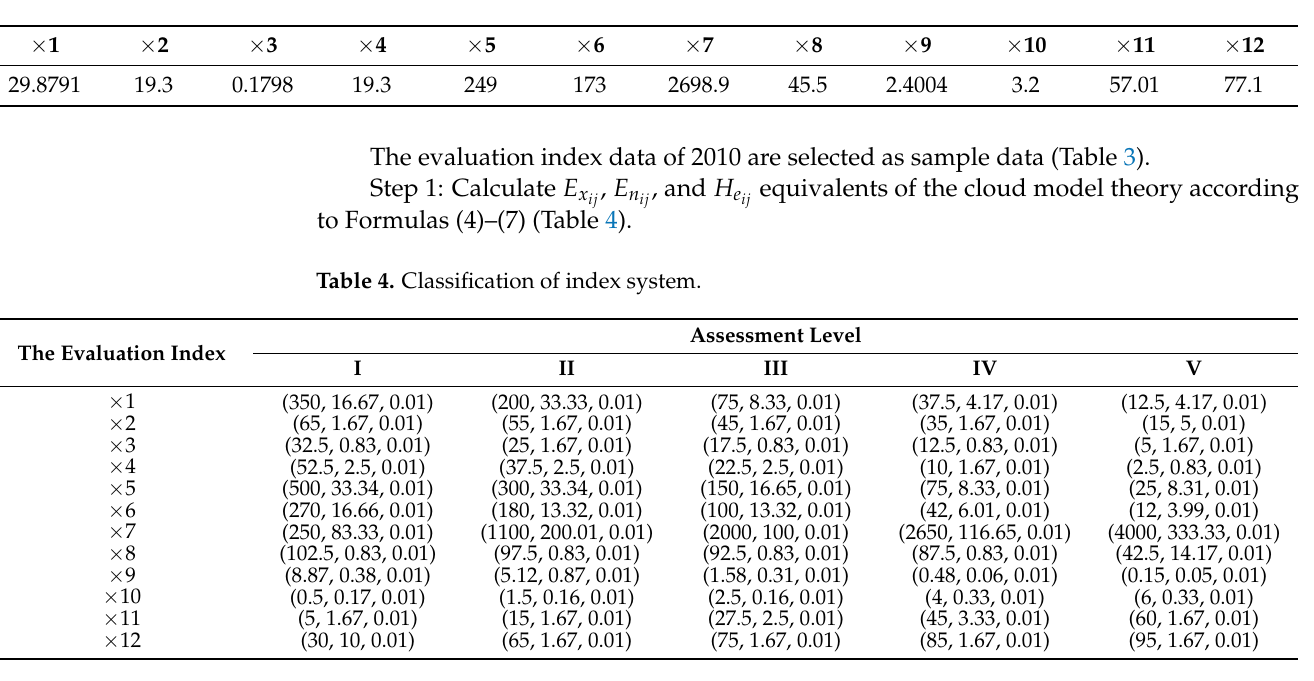
Table 3. Index data of 2010.